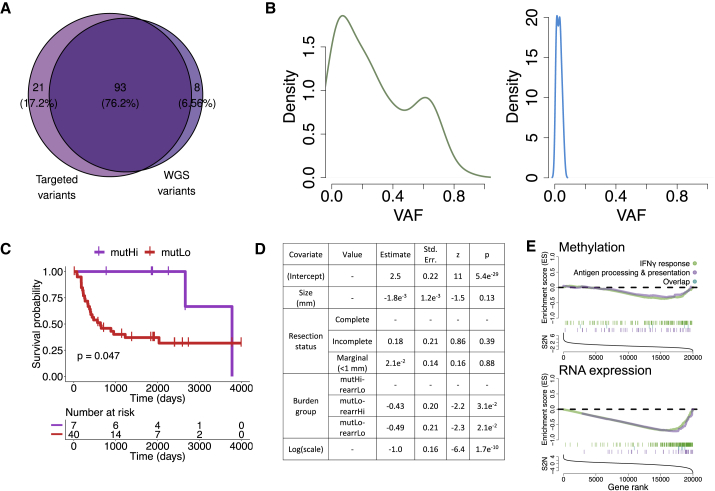
Implications of Increased Tumor Mutational Burden(A) Venn diagram of predicted pathogenic variants from mutHi samples identified from targeted sequencing (left) and identified from WGS in regions overlapping the design of the targeted baitset (right).(B) Variant allele frequency (VAF) of all variants (left) or variants only observed by targeted sequencing (right).(C) Overall survival of patients stratified by mutational burden and with a univariate Kaplan-Meier model.(D) Multivariate accelerated failure time model for progression-free survival with size of tumor, resection status, and burden group as covariates.(E) Gene set enrichment analysis for interferon gamma response (green) and antigen presentation (purple) pathways using both DNA methylation (top) and gene expression (bottom) data comparing the mutHi-rearrLo group against all others. See also Table S3.